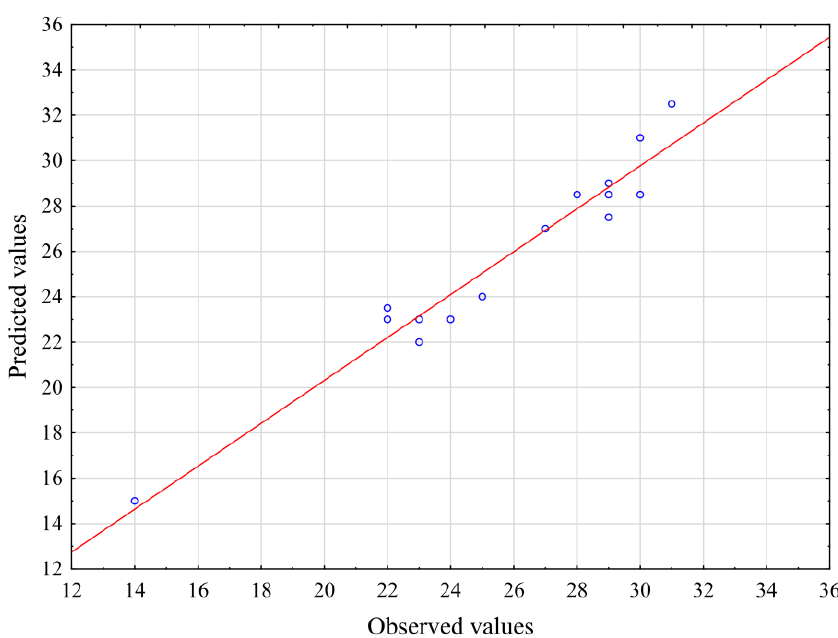
FIGURE 1 - The correlation between observed and predicted values of inhibition zone diameter against Neurospora crassa